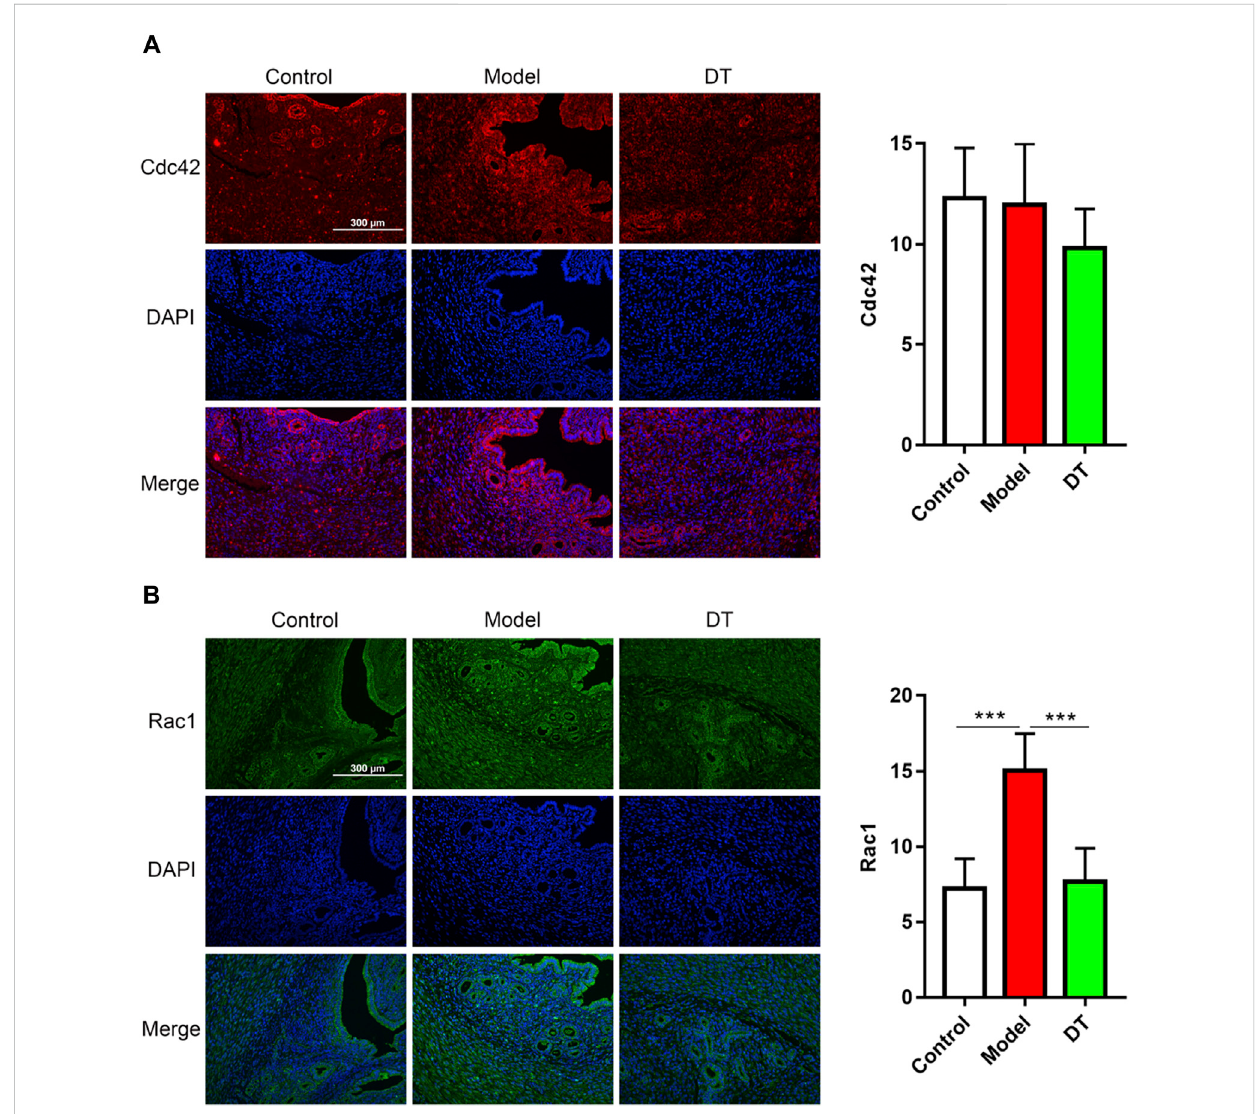
FIGURE 10 Immuno fl uorescence assay of Cdc42 (A) , red and Rac1 (B) , green and quantitativeanalysis of Cdc42 and Rac1. Data were expressed as means± SD, ***p < 0.001 versus the model group.